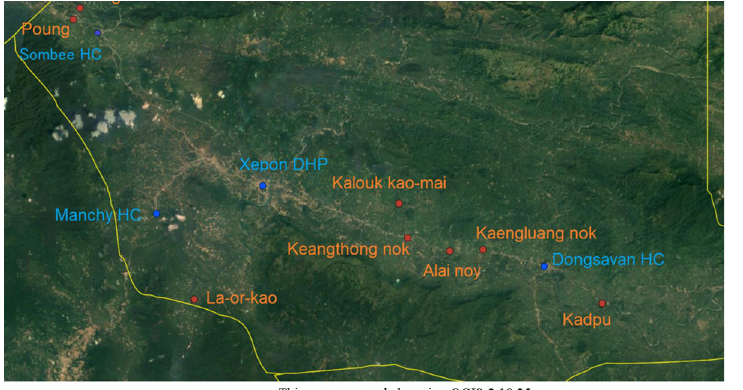
Fig 1. Map of the study site (Xepon district) with village